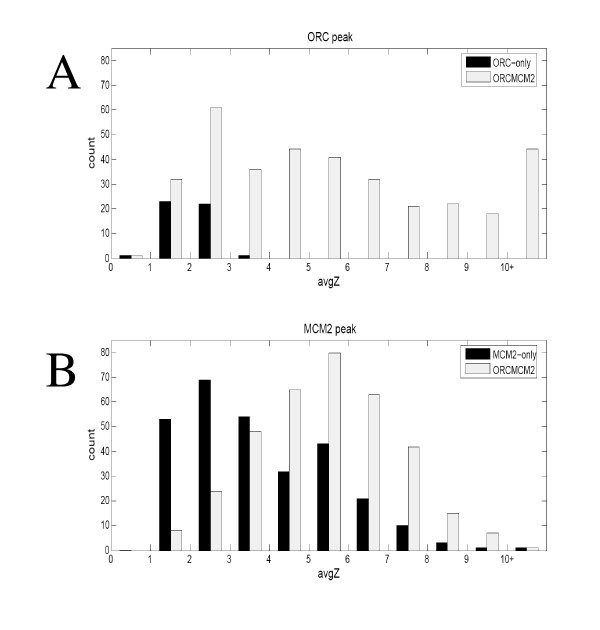
Peak strength in the three classes of binding sites. A. Comparison of ORC peak strength within ORC-only sites and ORC-MCM2 sites. B. Comparison of MCM2 peak strength within MCM2-only and ORC-MCM2 sites.